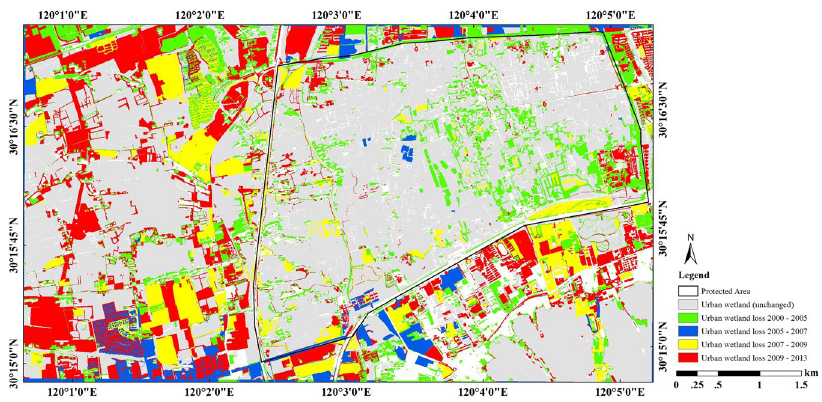
Figure 4. Urban wetland loss from 2000 to 2013. This figure was created using ArcGIS ® software by ESRI. ArcGIS 10.2 and ArcMap 10.2 are the intellectual property of ESRI and are used here under license. For more information about ESRI software, please visit